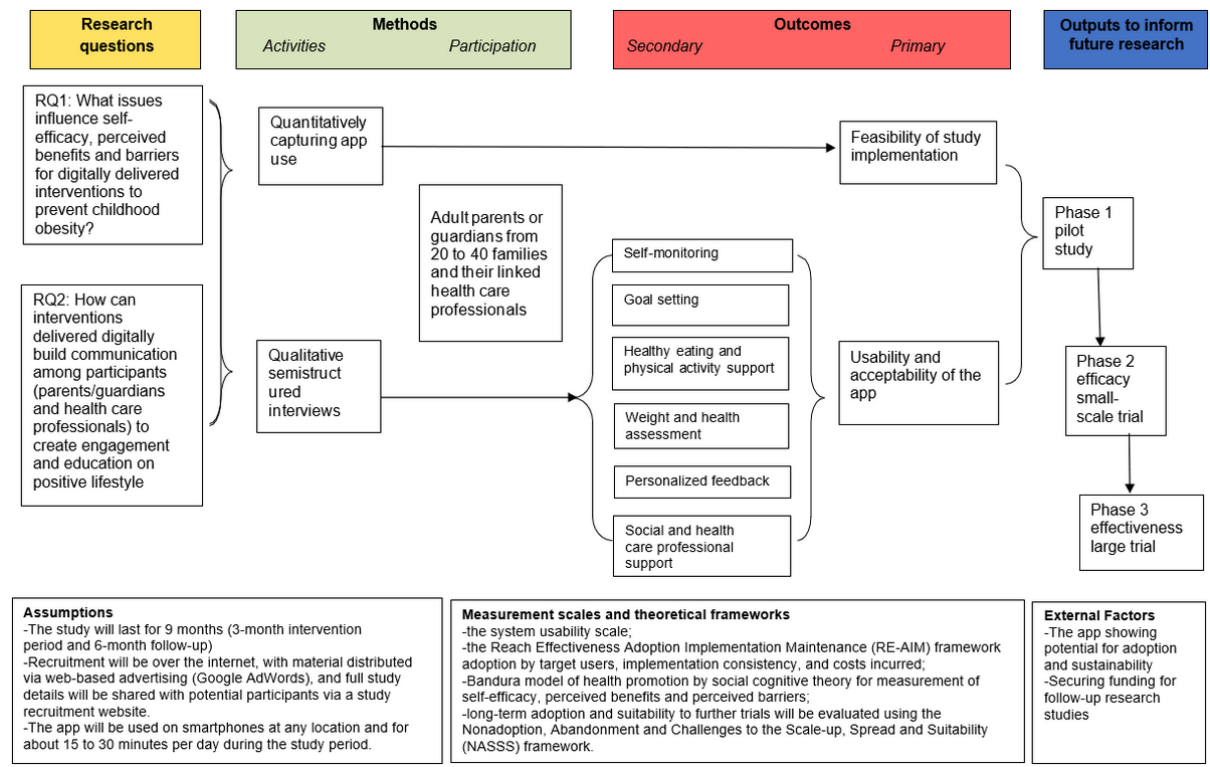
Figure 3. Study logic